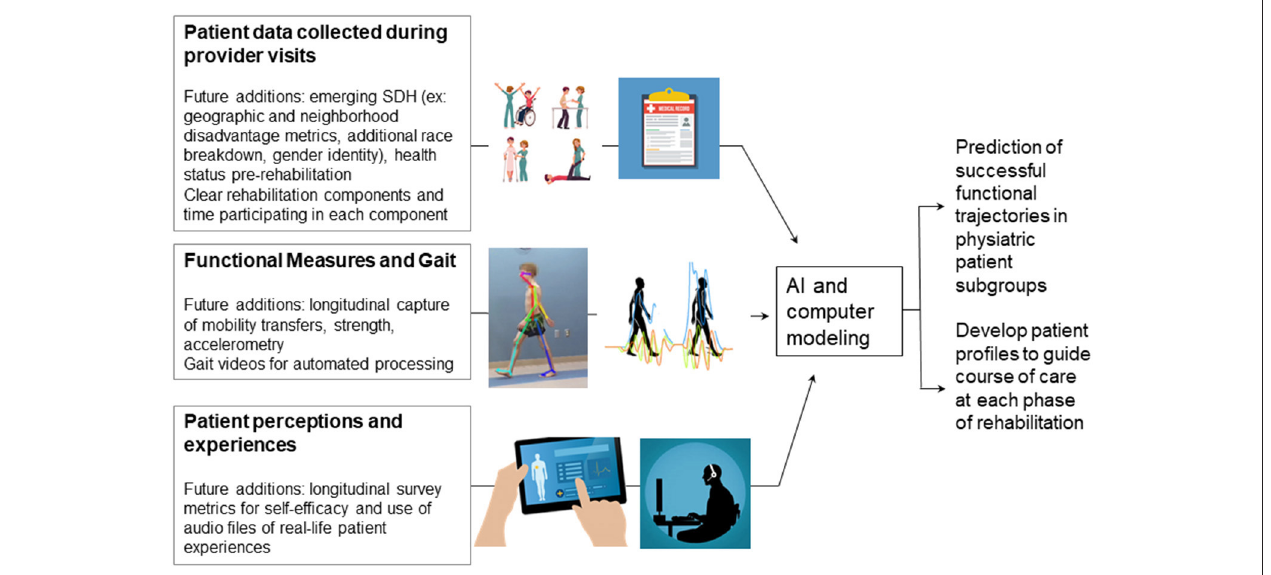
FIGURE 2 | Proposed functional and performance metrics and processes to improve prediction of functional trajectories in patients with physiatric diagnoses. SDH, Social determinants of health; AI, Artificial